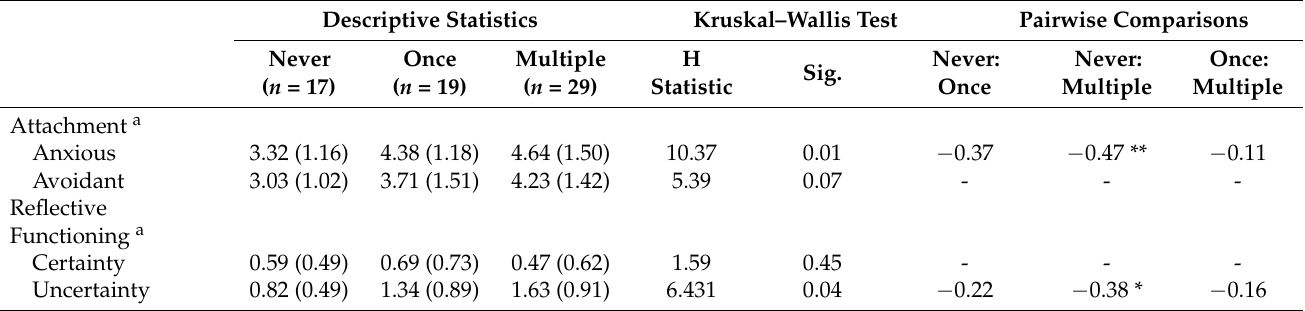
Table 5. Differences between participants with no previous suicide attempts, one previous attempt or multiple previous attempts.